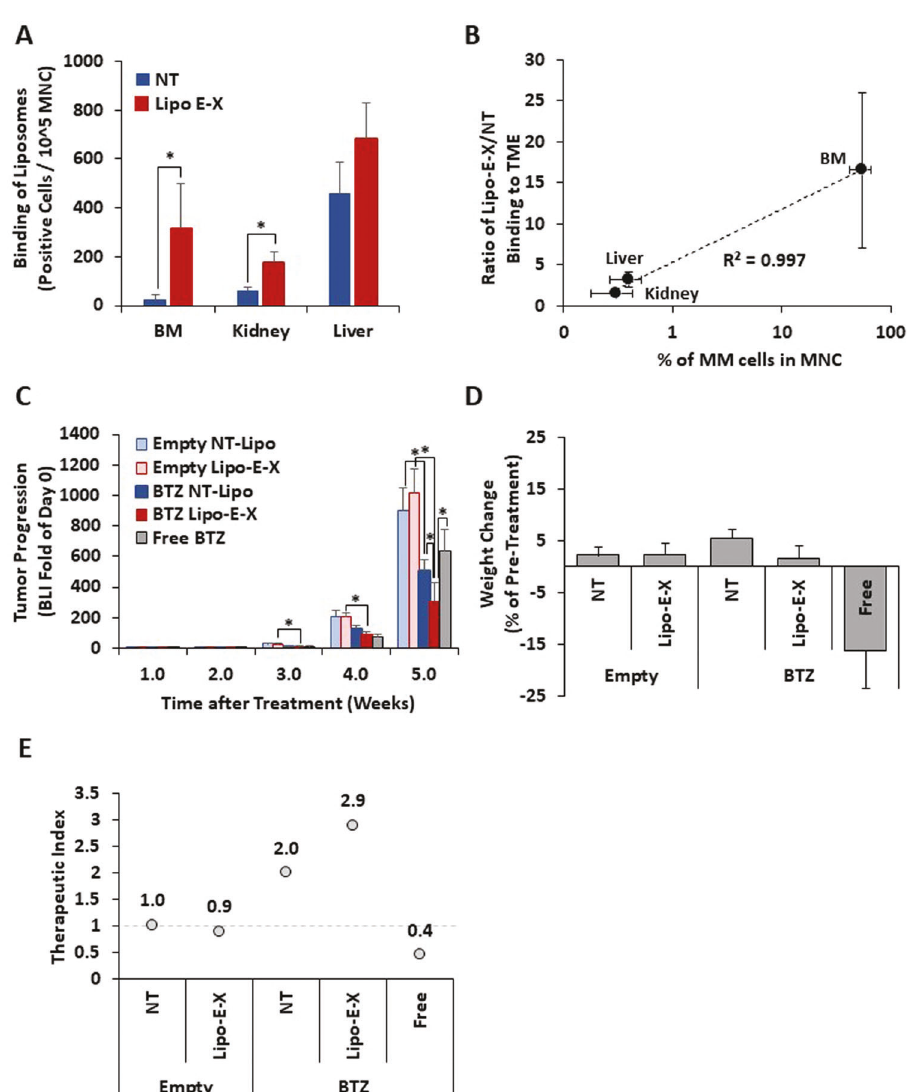
Fig. 2 E-selectin-targeting Lipo E-X lipid nanoparticles speci fi cally accumulate in the BM of MM-bearing mice and improve the ef fi cacy and reduce the side effects of BTZ in vivo. A MM.1S-GFP-Luc cells (2 × 10 6 cells per mouse) were injected intravenously (IV) into immunode fi cient mice ( n = 4, NCG mice, 8-week-old, Charles River Laboratories). The disseminated tumor developed over the next four weeks, which was con fi rmed using BLI. Pre-labeled non-targeted liposomes (DiI) and E-Selectin-targeted Lipo-E-X liposomes (DiD) were mixed in a 1:1 ratio and injected IV at 1 mg/100uL liposomes per mouse. For the biodistribution and binding ef fi cacy determination of these two formulations, mice were sacri fi ced 24 h post-liposome injection. BM, kidney, and liver were harvested, washed, fi ltered, run using fl ow cytometry, and analyzed for the mean fl uorescence intensity (MFI) of DiI and DiD in MM-GFP + cells, as well as in GFP- population, i.e., tumor microenvironment using the FlowJo ® software. Biodistribution of fl uorescently labeled non-targeted and Lipo E-X targeted lipid (number of positive cells per 10 5 of MNCs) in different organs in MM-bearing mice, was determined 24 h following a single iv injection. B The correlation between the ratio of Lipo E-X/non-targeted lipid nanoparticles binding and the presence of MM-GFP + cells (% of MNCs) in different organs. C MM.1S-GFP-Luc cells were injected intravenously into immunocompromised NCG mice ( n = 40). Tumor progression was con fi rmed using BLI at two weeks post-injection, and (5) BTZ as a free drug. Then mice were randomized into 5 groups of 8 mice each and treated once a week with: (1) empty non-targeted liposomes, (2) empty Lipo E-X liposomes, (3) BTZ-loaded non-targeted liposomes, and (4) BTZ-loaded Lipo E-X liposomes. All liposomal formulations (empty or loaded) were given at 10 mg/kg of liposomes, and BTZ-treated groups (free or liposomal) were given at an equivalent dose of 1 mg/kg. Tumor progression was assessed weekly by BLI and normalized to day 0 (initiation of post- treatment). D Percentage of weight change of mice in each group at week 5 normalized to their weight pre-treatment. E The value of the therapeutic index of different formulations of bortezomib in vivo. Each quanti fi ed value is presented as mean ± standard deviation from four biological replicates, and we used an unpaired Student ’ s t-test (* p < 0.05) for statistical signi fi